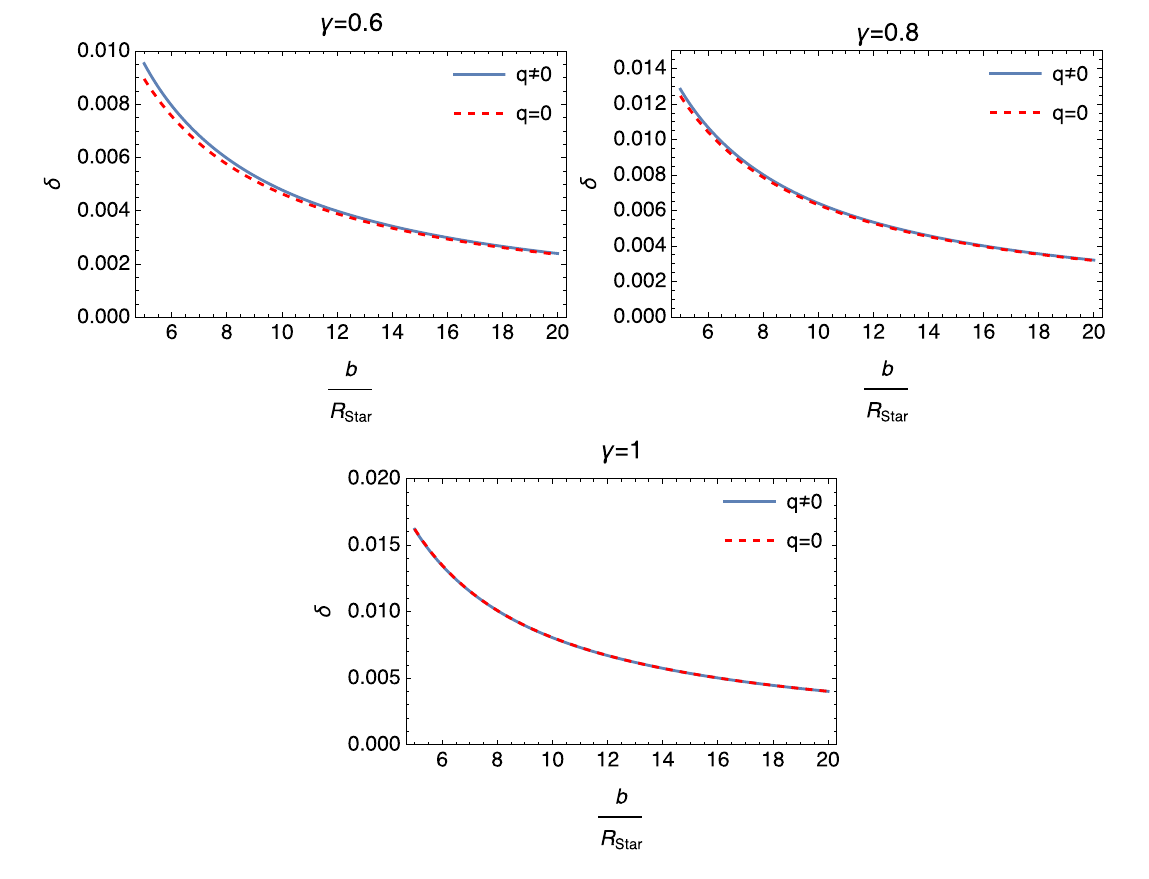
Fig. 6 Similar plot of δ versus x for the SAX J 1808 . 4 − 3658 star